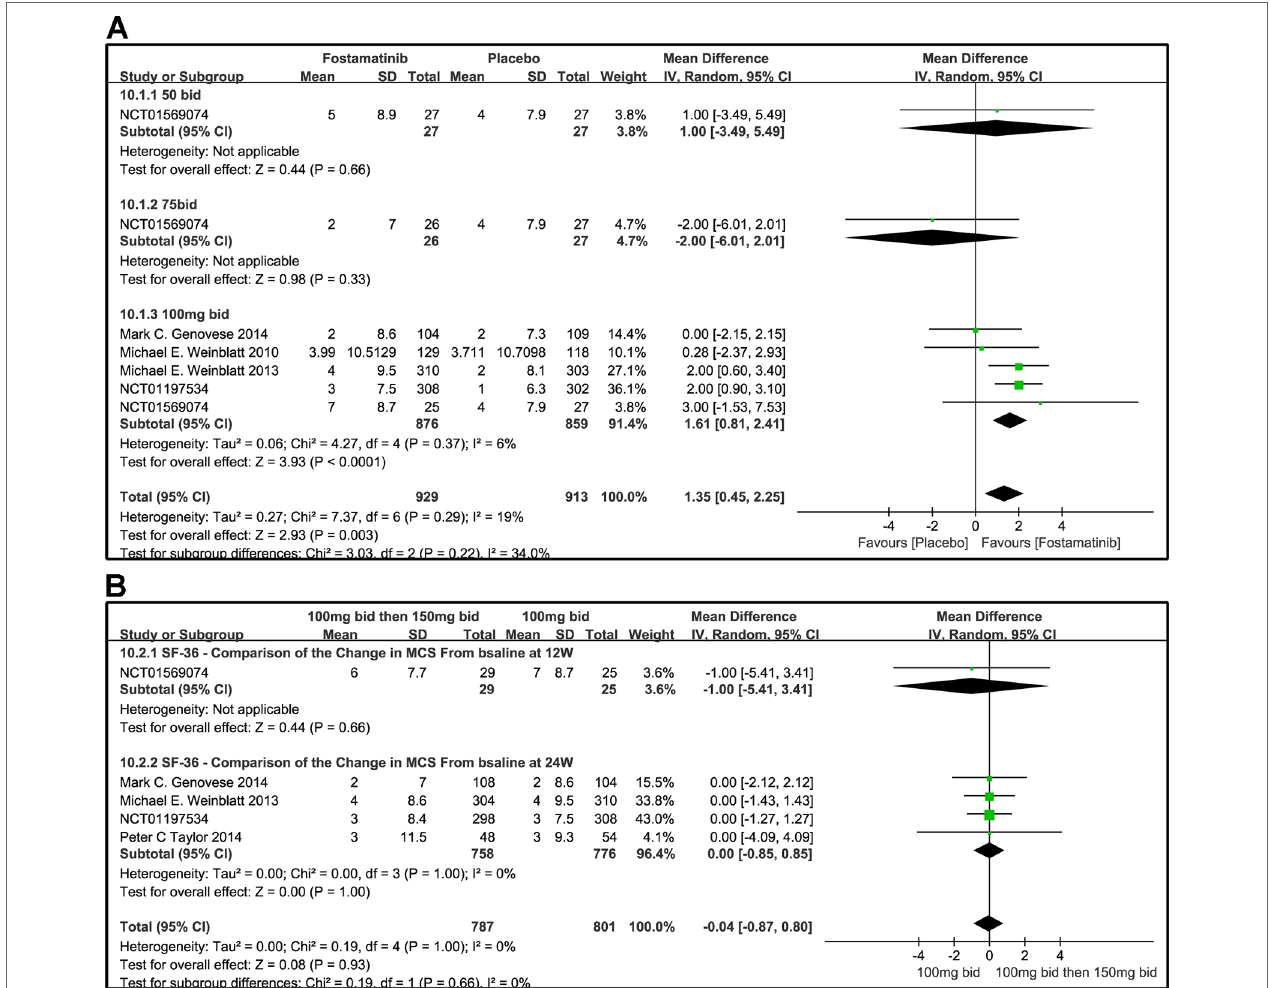
FIGURE 11 | Forest plots for the effect of multiple doses on SF-36 to derive the change in MCS at different time points. (A) Subgroups administered multiple doses (50, 75, and 100 mg bid) of fostamatinib vs. placebo at 24 weeks; (B) 100 mg bid for 4 weeks followed by 150 mg bid vs. 100 mg bid at 12 and 24